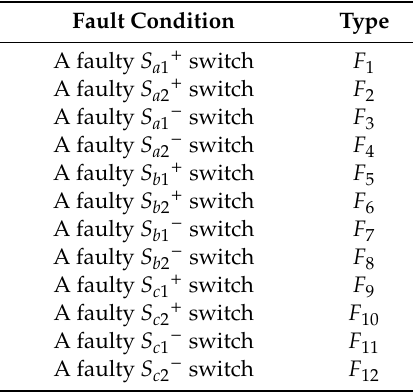
Table 1. Types of fault diagnosis.